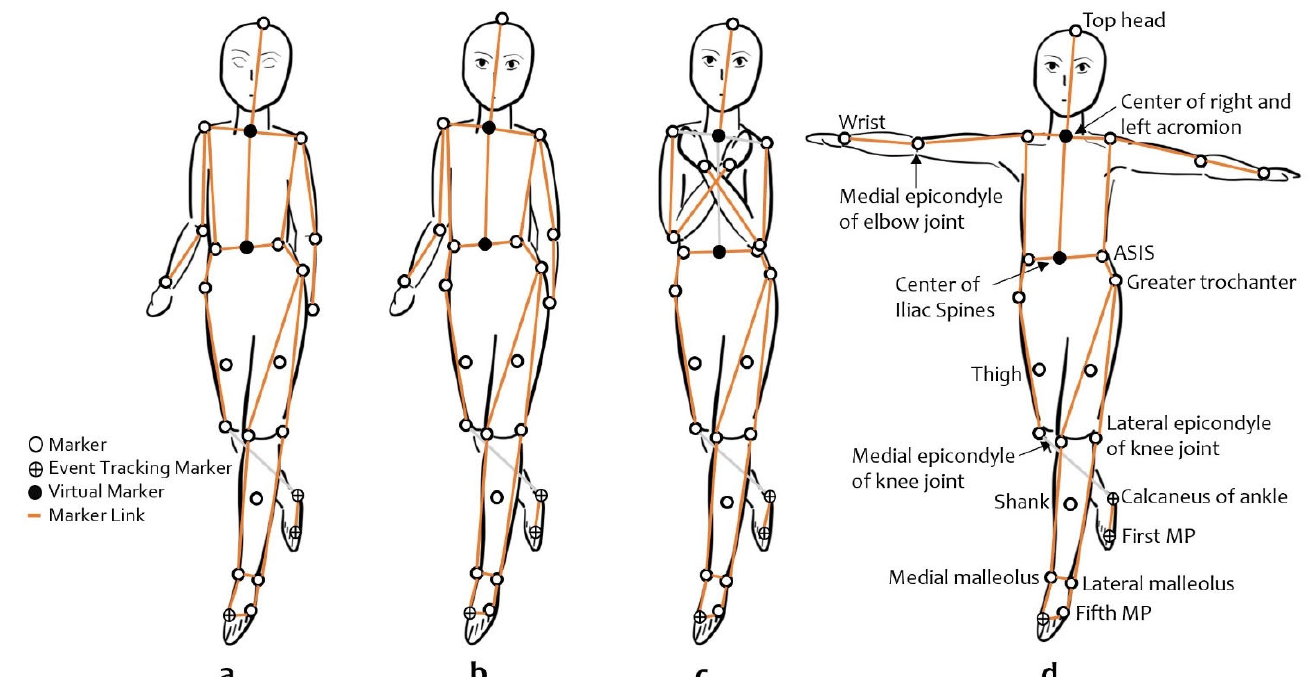
Figure 1. Backward walking conditions at self-selected speeds show a subset of the markers used for gait analysis: ( a ) closed eyes backward walking; ( b ) normal backward walking, the control condition used to analyze the effect of arm swing and visual feedback, where participants walked independently at a comfortable speed with arm movements; ( c ) crossed arms backward walking condition; ( d ) abducted arms backward walking condition is the posture similar to a T-pose. MP—metatarsophalangeal joint; ASIS—anterior superior iliac spine.